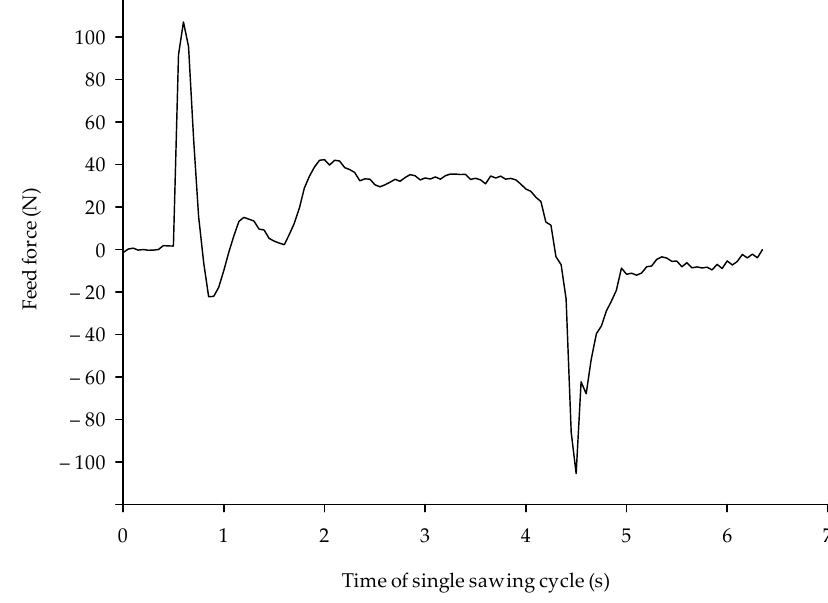
Figure 3. Force signal for a single sawing cycle for the 12 m/s feed rate. The steady-state mean feed forces ( F f ) for three feed rates changing with the progressing real length of cut ( L t ) made by each tooth of the saw are shown in Figure 4. Each of the three cases were tested with the same length of kerf (150 m), but the total length of cut was different because of different feed per tooth values. The logarithmic regression equations of feed forces (given in N) for 12, 18, and 24 m/min feed rates, as functions of the length of cut (given in meters), are as